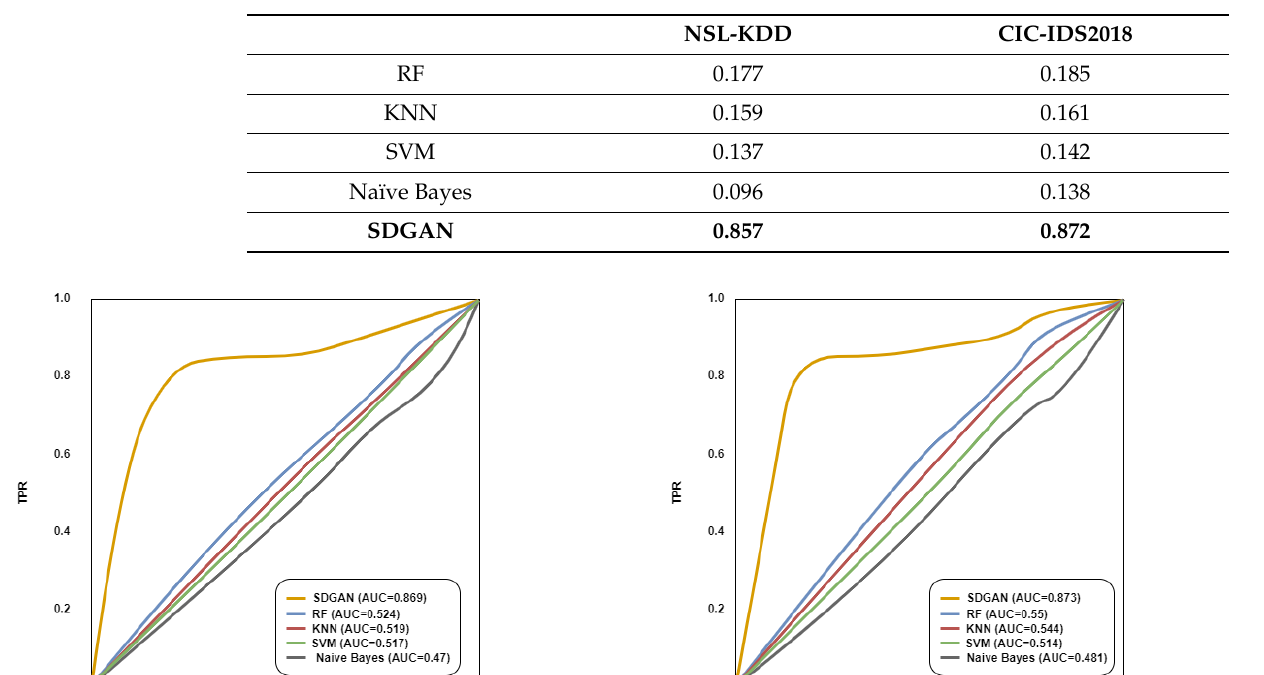
Table 8. TPRs of ML-based DDoS detectors and SDGAN on adversarial DDoS attacks.